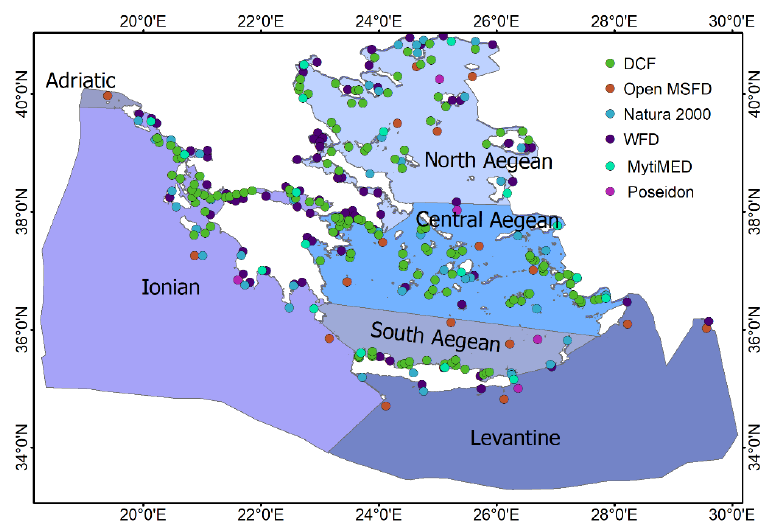
Figure 12. The Greek MSFD monitoring network integrating the data collection frameworks and the Natura 2000, WFD, Mytimed, Poseidon, and open sea MSFD networks.